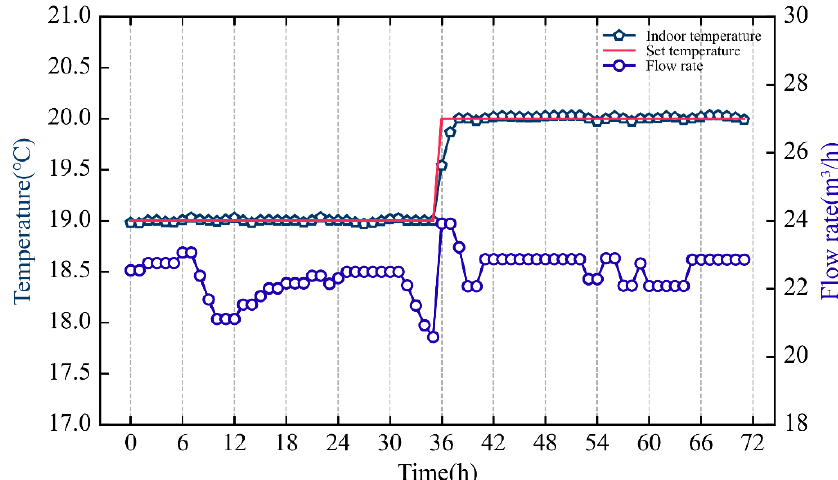
Figure 14. Simulation results in building B when the set temperature